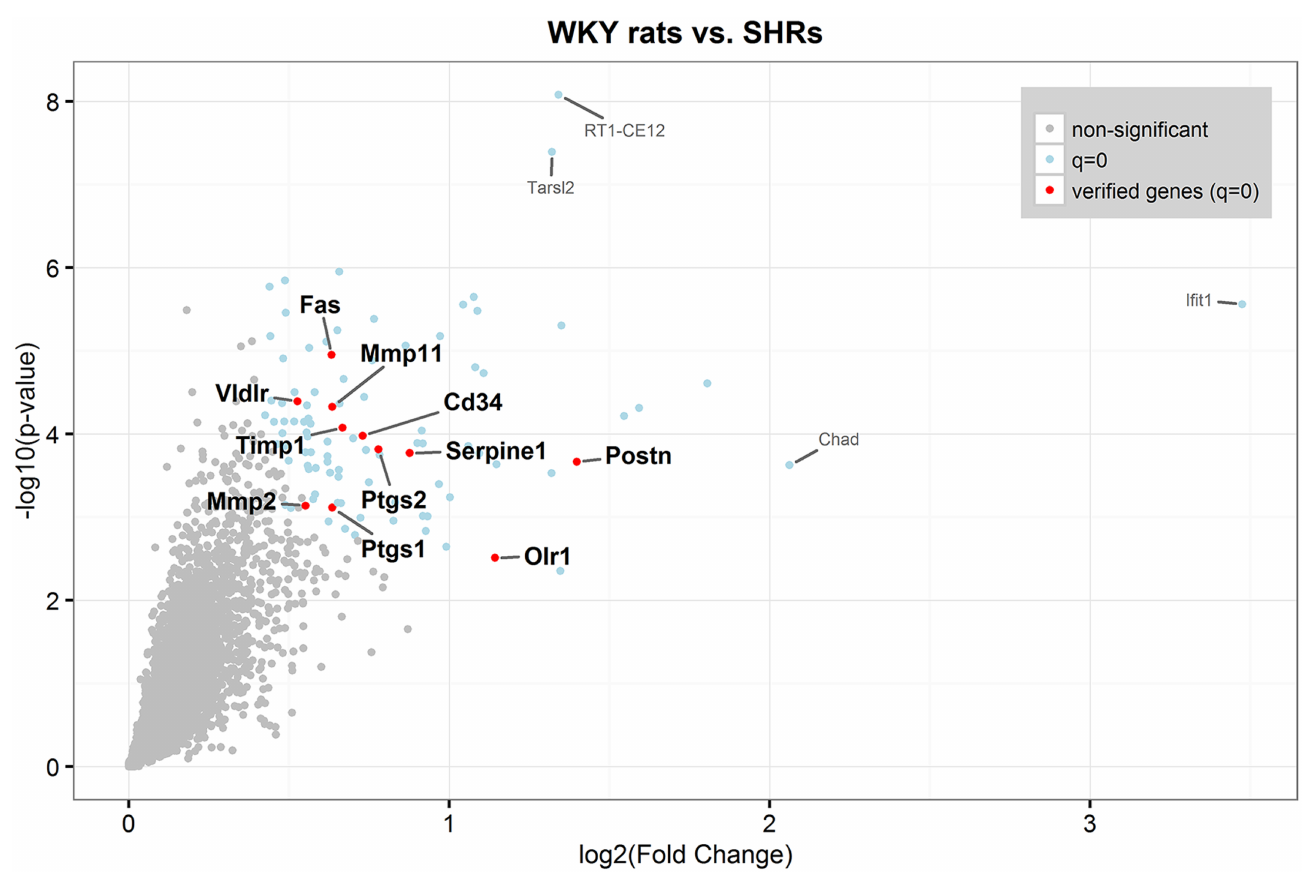
Fig 2. Volcano plot. Red and blue dots are differentially expressedgenes (q = 0) in the MCAs from SHRs (n = 5) comparedto WKY rats (n = 5). Red dots are genesverified by qPCR.